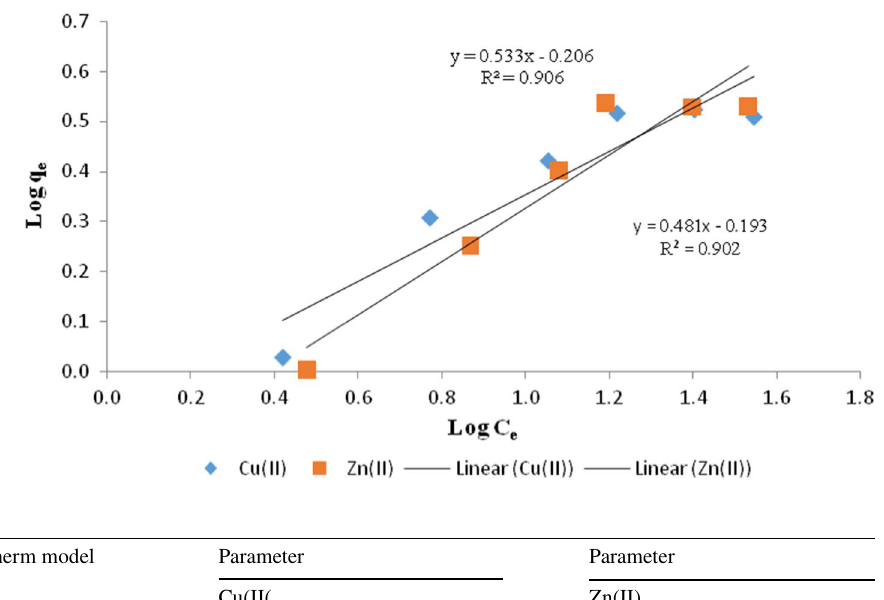
Table 2 The parameters of Langmuir and Freundlich isotherms of adsorption of copper and zinc on E.